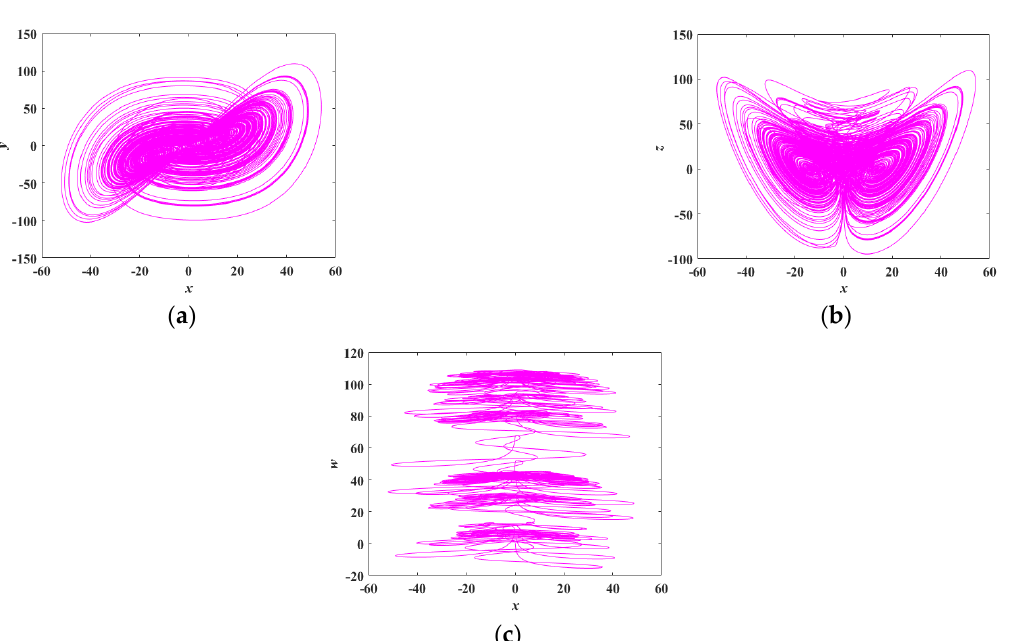
Figure 1. Phase diagram of discrete system, ( a ) x-y plane, ( b ) x-z plane, ( c ) x-w plane.